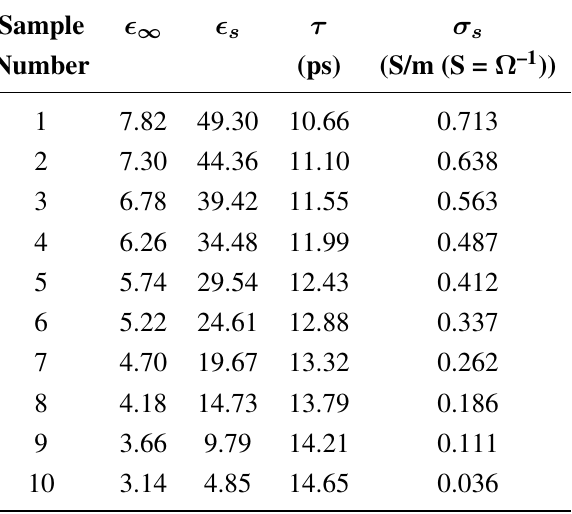
Table 1. Dielectric properties of the linear range of tissues used in the simulations.